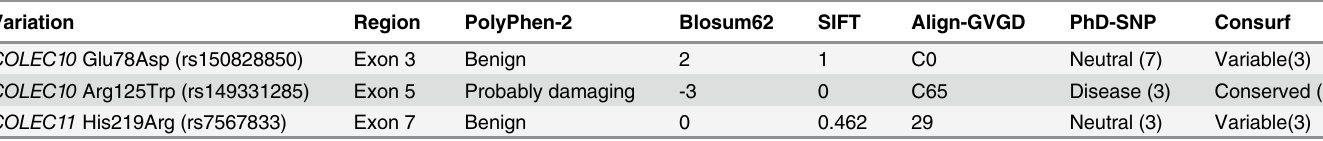
Table 4. Non-synonymous variations in COLEC10 and COLEC11